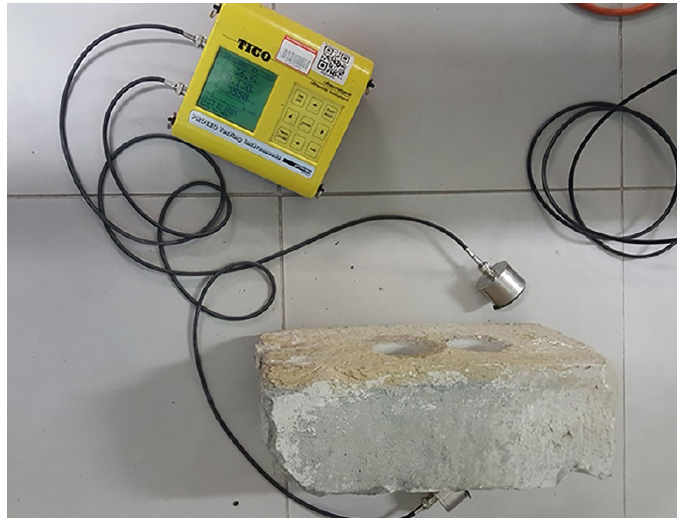
Figure 4. Ultrasonic test setup.